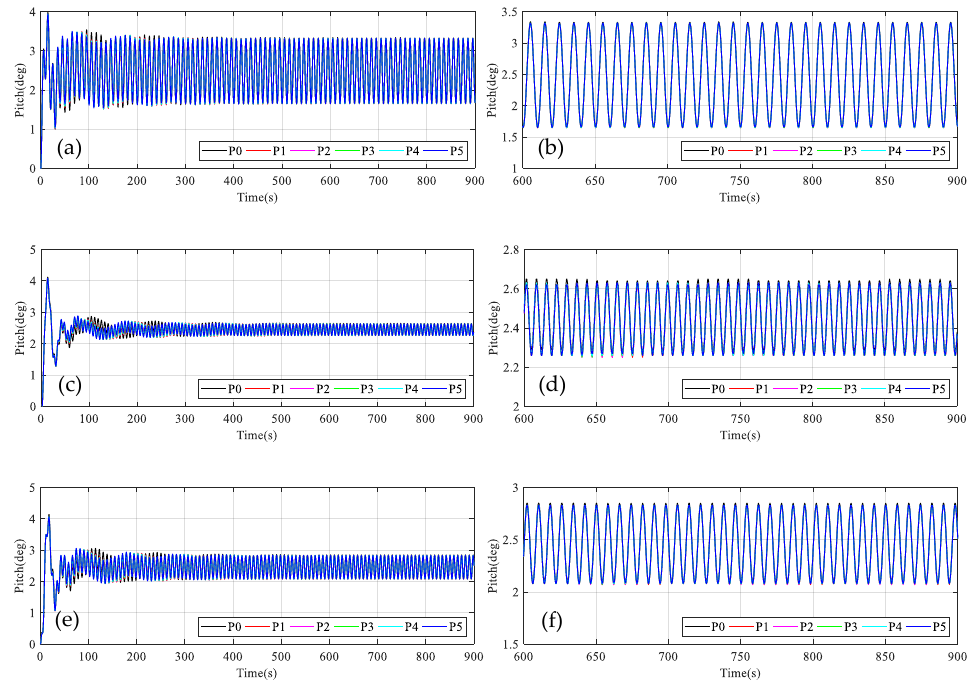
Figure 7. Pitch motion from 0 s to 900 s for ( a ) case 1, ( c ) case 2, and ( e ) case 3, and from 600 s to 900 s for ( b ) case 1, ( d ) case 2, and ( f ) case 3.